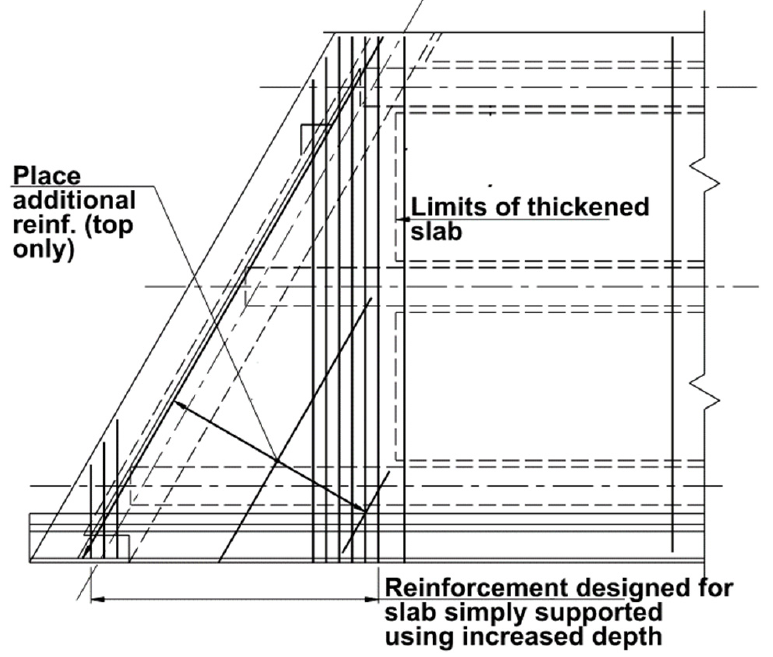
Figure 1. The current acute corner detail from Connecticut Department of Transportation